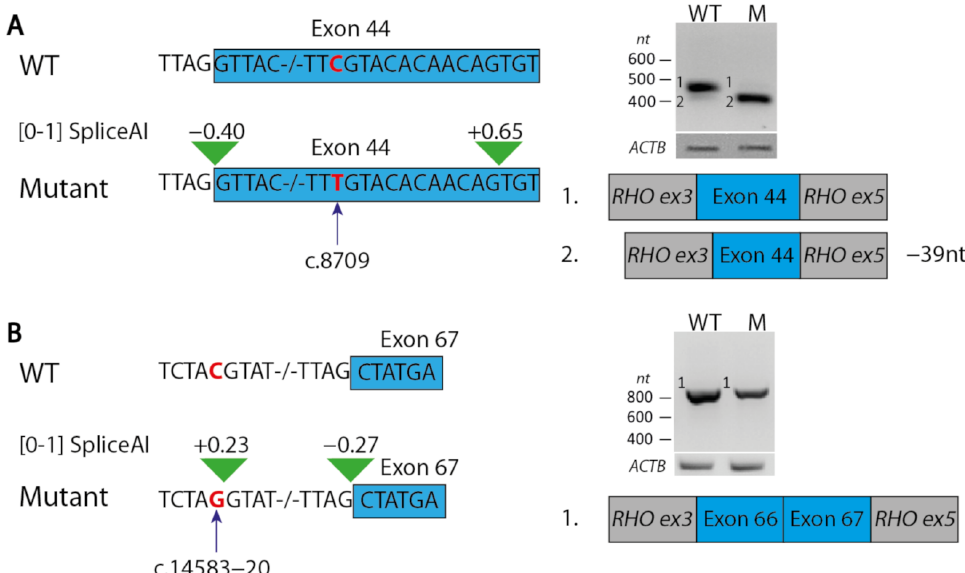
Figure 2. Results of minigene splice assays for variants c.8709C>T and c.14583 − 20C>G. ( A ) Variant c.8709C>T (indicated in red) is predicted by splice prediction tool SpliceAI to result in a 39-nt deletion of exon 44 in the USH2A transcript. This effect was indeed observed in a splice assay for the construct containing the variant (M), but not for the wildtype construct (WT). ( B ) SpliceAI predicts an increased strength of a non-canonical splice donor site due to variant c.14583 − 20C>G. A splice assay did not demonstrate the use of this splice site as no elongation of exon 67 was observed. Exonic sequences are boxed (blue). Green triangles indicate SpliceAI predictions.